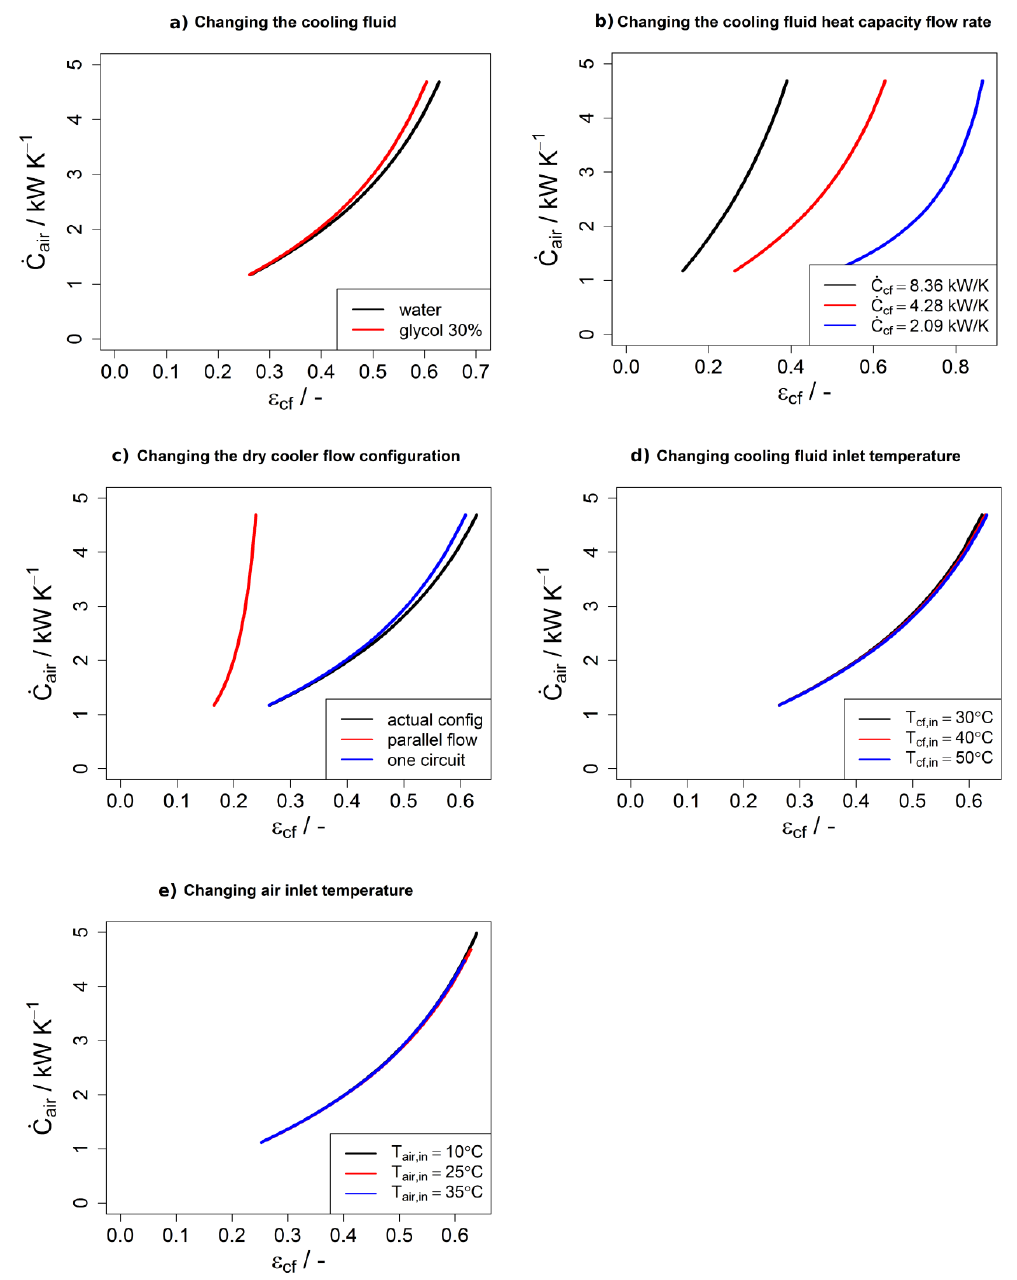
Figure 2. Dependency of cooling fluid capacity flow rate versus cooling effectiveness on different parameters. Other parameters than the changed parameters are constant. Further explanation is given in the text. ( a ) Changing the cooling fluid; ( b ) Changing the cooling fluid heat capacity flow rate; ( c ) Changing the dry cooler flow configuration; ( d ) Changing cooling fluid inlet temperature; ( e ) Changing air inlet